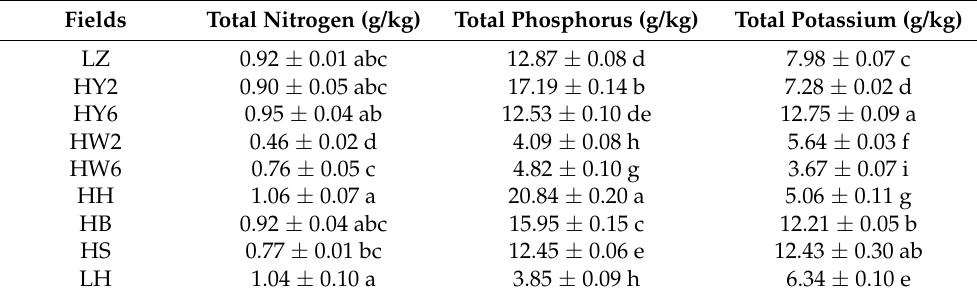
Table 2. Soil total content of nitrogen, phosphorus, and potassium in different continuous cropping